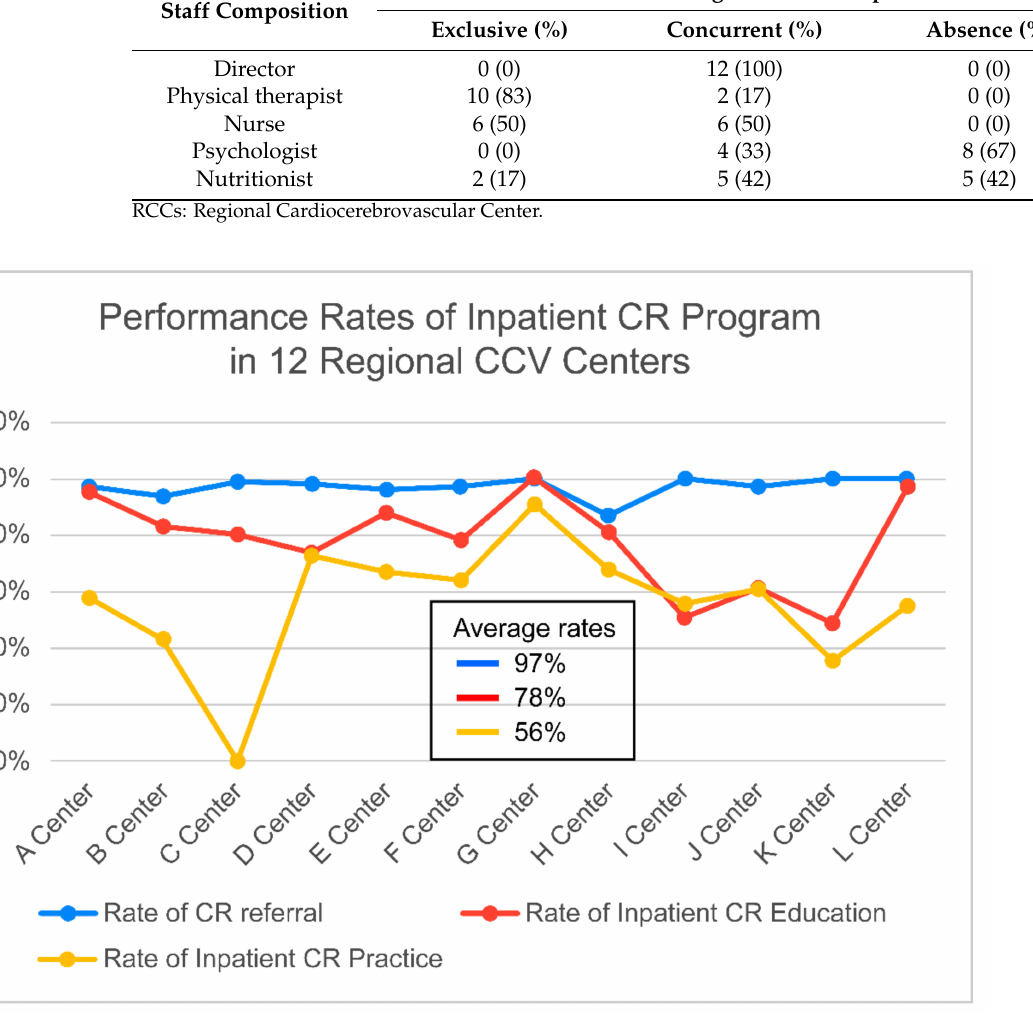
Figure 2. Performance Rate of Inpatient CR Program in 12 RCCs. CR: cardiac rehabilitation, RCC: Regional Cardiocere- brovascular